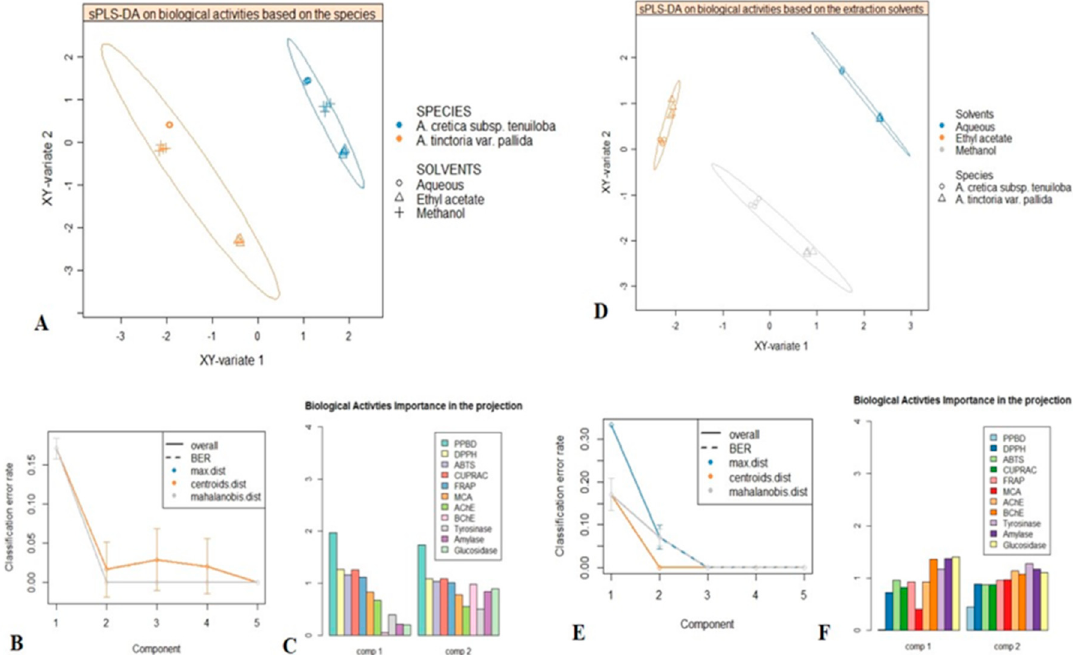
Figure 2. Supervised analysis with sPLS-DA. A : sPLS-DA samples plot with confidence ellipse plots considering the species as class membership criteria. B : Performance of the model (BER) for three prediction distances using 10 × 5-fold cross-validation. C : VIP score plot displaying the biological activities having highly contributed to the discrimination of both studied species. D : Factorial plan 1-2 of the sPLS-DA with confidence ellipse plots according to the extraction conditions as class membership criteria. E : The model performance per component for the three prediction distances using 5-fold cross-validation repeated 10 times. F : VIP score plot showing the biological activities outlining the difference between the three extraction conditions